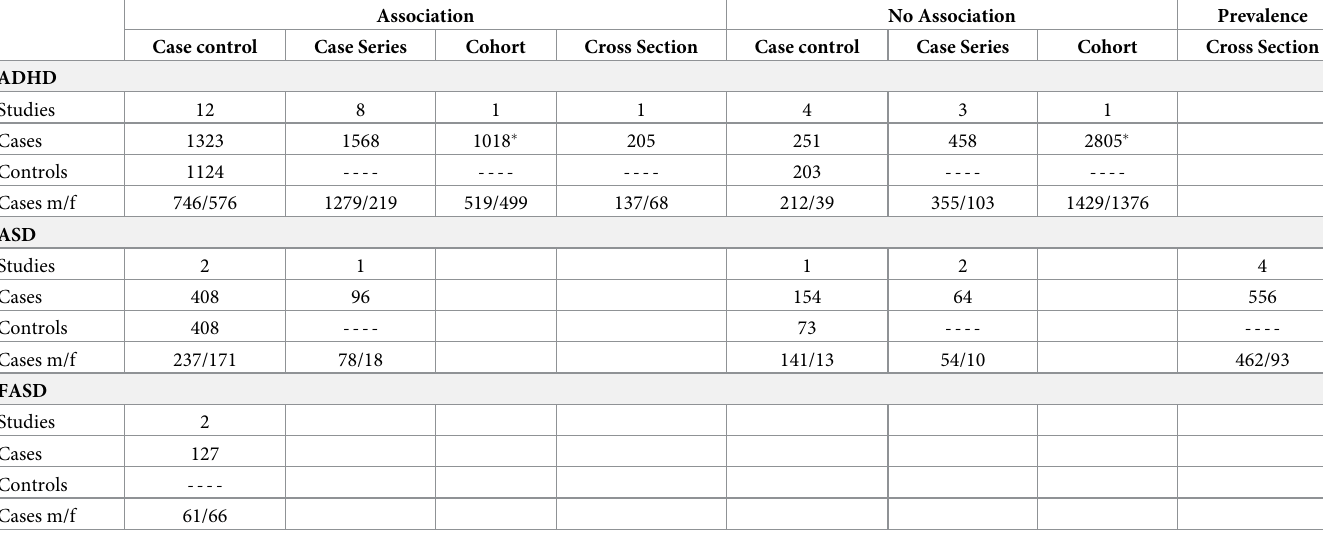
Table 2. Overview of studies investigating the association of ID and an NDD and / or prevalence studies.